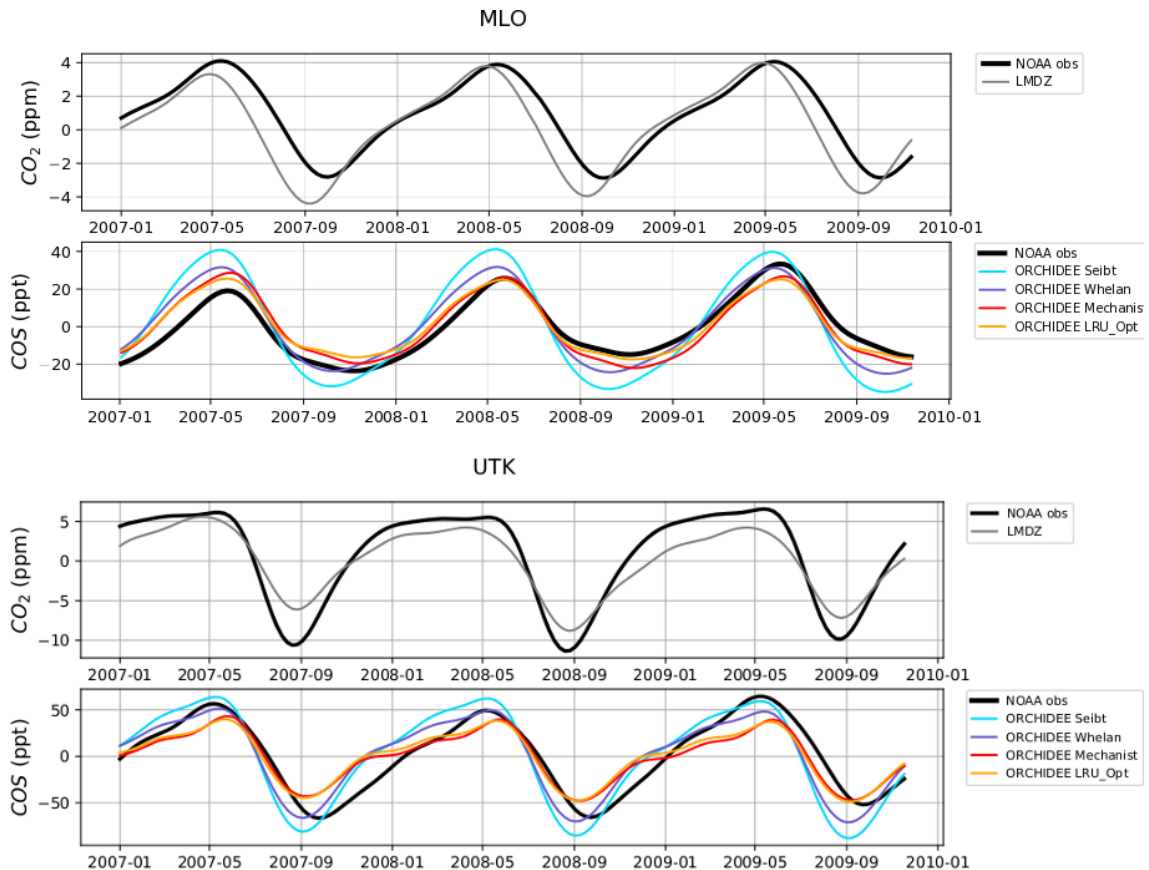
Figure 8. Detrended temporal evolutions of simulated and observed CO 2 and COS concentrations at two selected sites, for the mechanistic (ORCHIDEE Mechanist) and LRU approaches (ORCHIDEE Seibt, ORCHIDEE Whelan, ORCHIDEE LRU_Opt), simulated with LMDz6 transport between 2007 and 2009. The ORCHIDEE LRU_Opt line (orange) corresponds to the concentrations simulated using the optimal LRU values derived from the mechanistic model. Top: Mauna Loa station (MLO, Hawaii); bottom: Utqia˙gvik station (UTK, Alaska). The curves have been detrended beforehand and filtered to remove the synoptic variability (see Sect. 2.2.4)